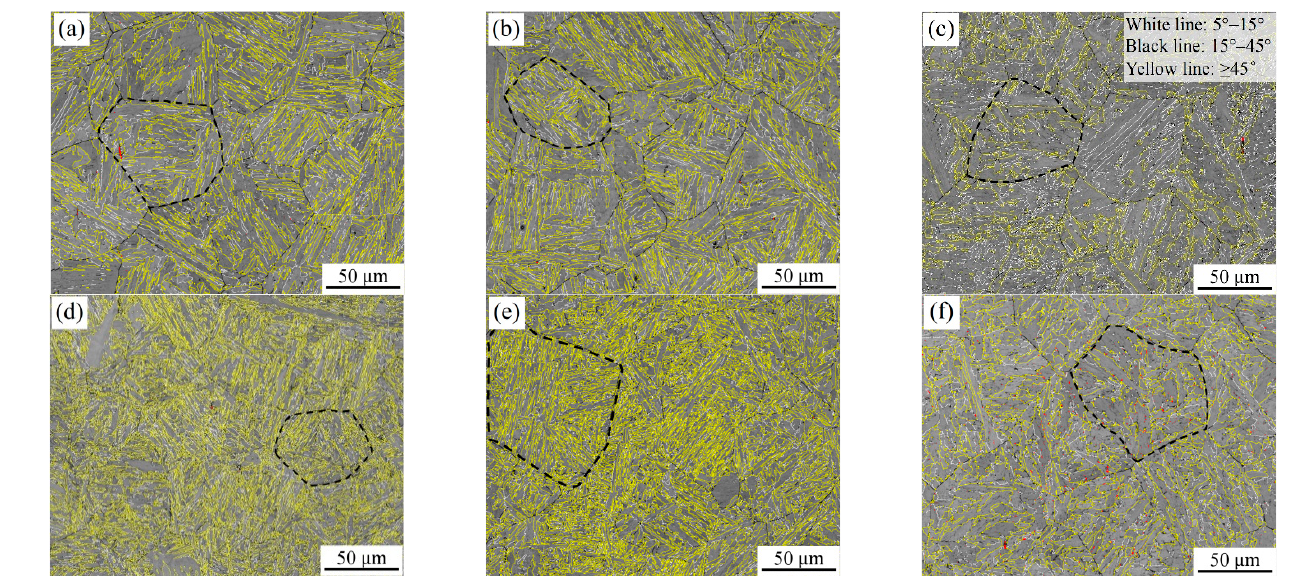
Figure 5. Boundary distributions of the simulated samples with 0.04 wt.% C ( a – c ) and 0.12 wt.% C ( d – f ) under the different heat inputs: ( a , d ) 10 kJ/cm, ( b , e ) 20 kJ/cm and ( e , f ) 50 kJ/cm.